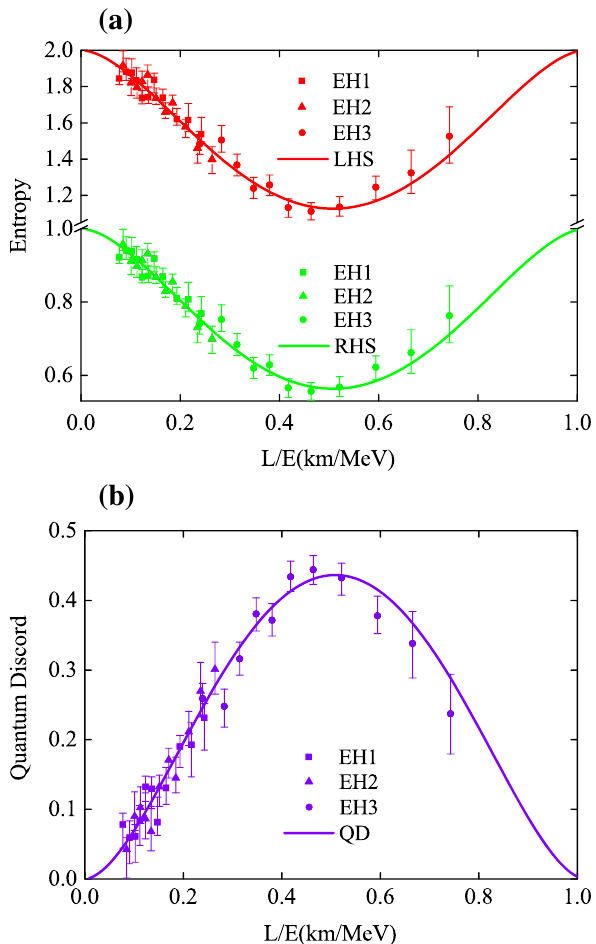
Fig. 5 The entropic uncertainty in Eq. (7), the uncertainty’s lower bound in Eq. (7) and the quantum discord in Eq. (9) in theory and experiment with the error bars in regard to the distance traveled per energy L / E for the initial electron flavor state. LHS (solid line, red) denotes the entropic uncertainty [the left-hand side of Eq. (7)]; RHS (solid line, green) is the uncertainty’s lower bound [the right-hand side of Eq. (7)]; QD (solid line, violet) is the quantum